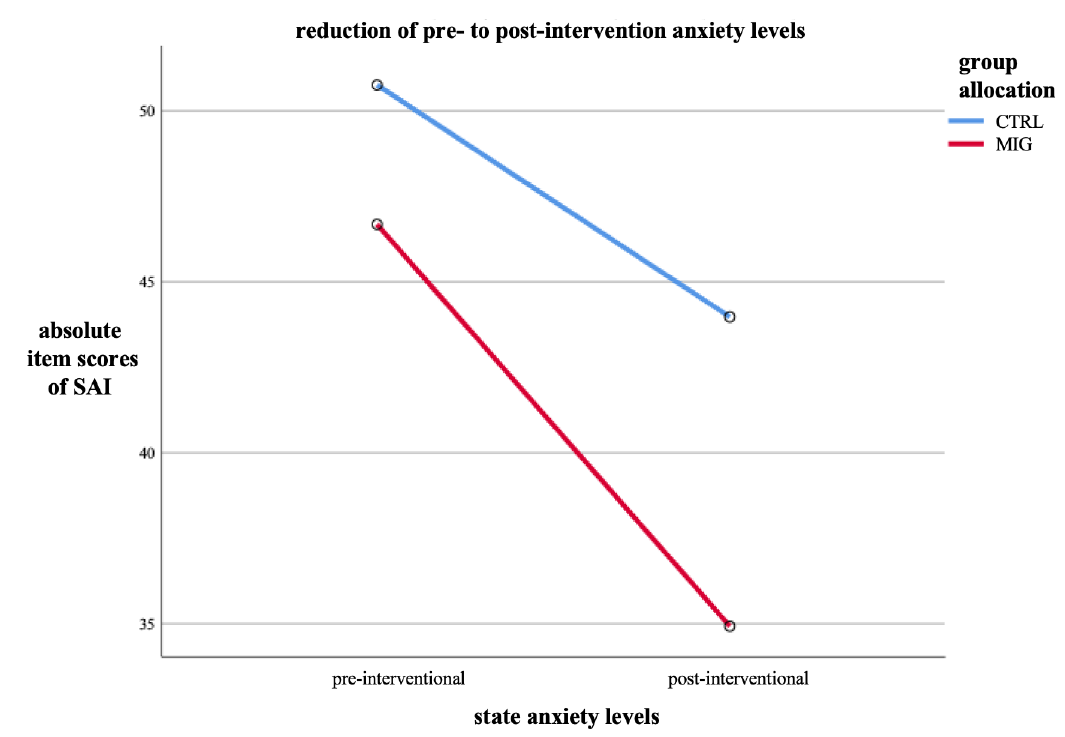
Figure 4. Reduction of averaged pre- and post-interventional state anxiety levels inventories among study groups as measured by the SAI, n = 72. CTRL control group; MIG music intervention group; SAI state anxiety